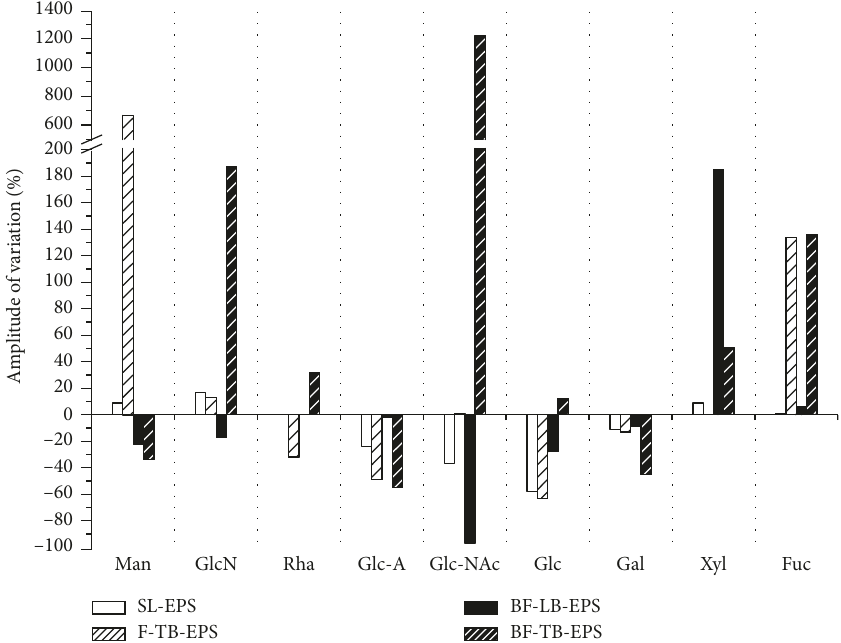
Figure 5: Variation amplitude for monosaccharides in EPS of diatom Stauroneis sp. treated by supernatant crude extract of Psychrobacter sp. SL-EPS and F-TB-EPS were prepared from the suspension phase of the treated diatom Stauroneis sp. culture, and BF-LB-EPS and BF- TB-EPS were prepared from the biofilm phase. Based on the HPLC profiles of samples and standard monosaccharides, the correction factors ( f 1/2 ), molar ratios ( R 1/2 ), and mole percentages were calculated. The amplitude of variation (%) for each monosaccharide in an EPS fraction was calculated as the variation (mole percentages) between the treatment and control divided by the mole percentage in the control.